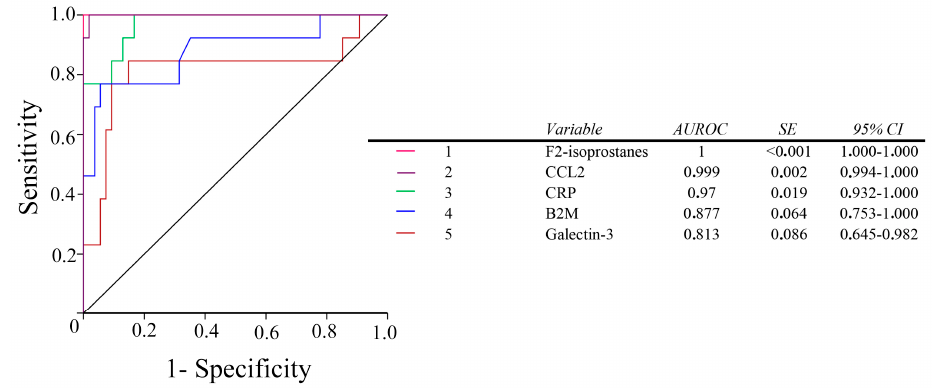
Figure 4. Selected biochemical variables in PAD patients classified according to whether they had mild disease (Fontaine Stages I and II) severe disease (Fontaine Stages III and IV), or were in the control group. Significance values by the Mann–Whitney U test: a p < 0.01; b p < 0.001, with respect to the control group.